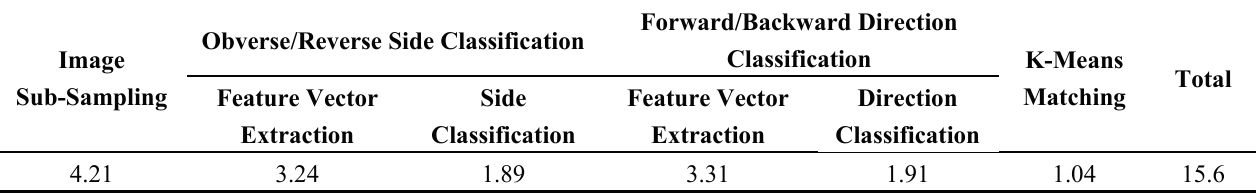
Table 9. Processing time of the proposed method on banknote counting machine (unit: